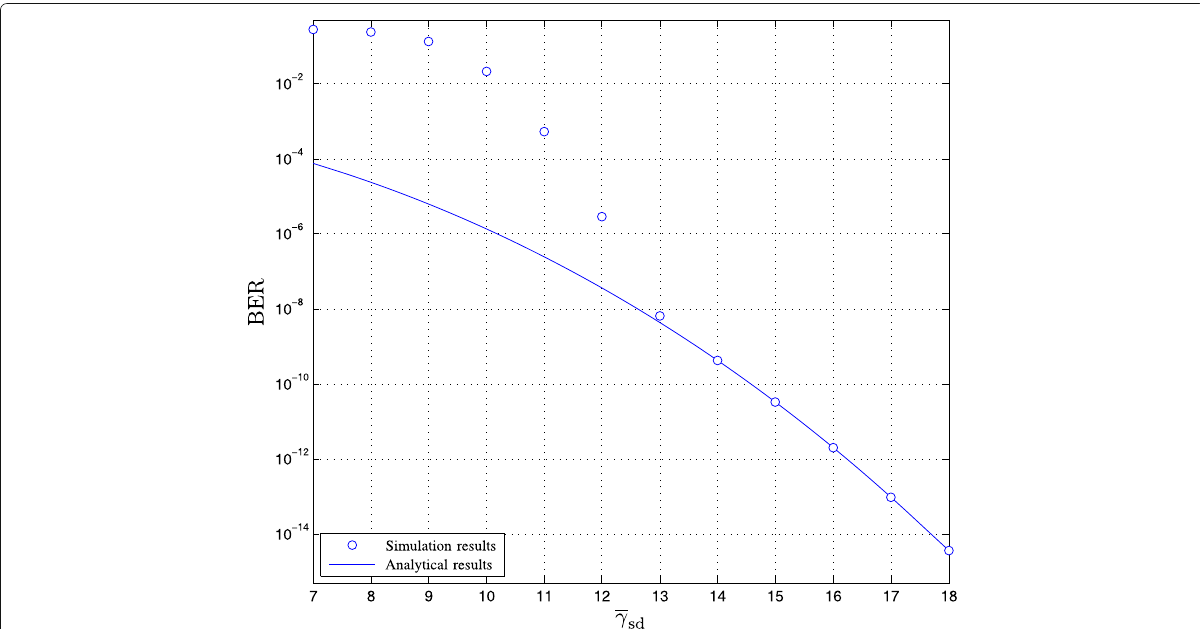
Fig. 5 BER of a two-hop cognitive relay channel as a function of γ sd using an UMTS turbo-coding scheme. With interleaver size N = 320, and for = d / d = 0.5 and I / P = 0 dB, lines correspond to the analytical results, hollow markers correspond to simulation results δ p rp rd